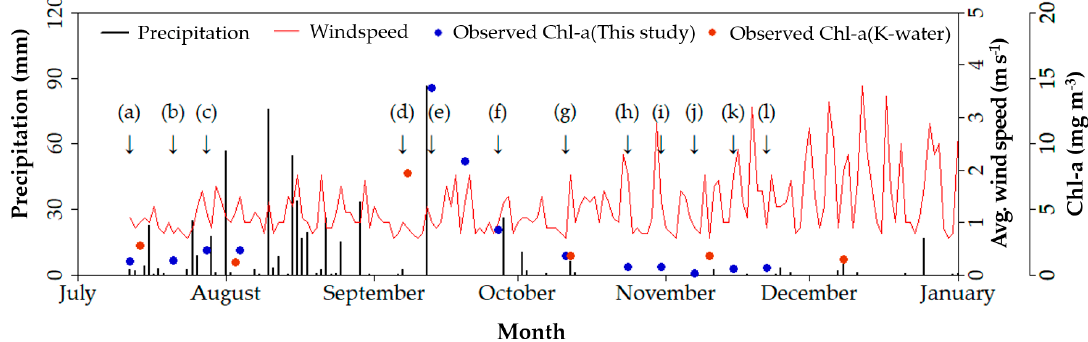
Figure 6. Temporal variations in daily precipitation, wind speed, and chlorophyll a concentration (Chl-a) during the monitoring period: the arrows indicate 12 campaign dates.